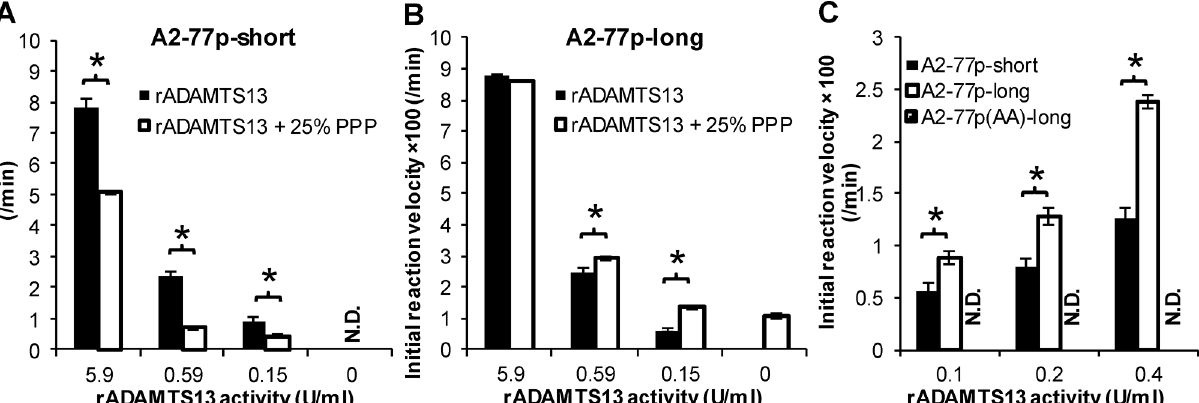
Fig 4. Effect of spacer length on proteolysis. A. A2-77p-short microspheres were incubated with varying concentrations of rADAMTS13 in the presence or absence of 25% plasma. Plasma failed to cleave A2-77p-short and also inhibited proteolysis of A2-77p-short by rADAMTS13. B. Experiments identical to panel A were performed, only using A2-77p-long. Here, plasma acts in synergy with rADAMTS13 to promote substrate cleavage. C. Direct comparison of the cleavage rates between A2-77p-short and A2-77p-long upon varying rADAMTS13 concentration. N.D. = cleavage not detected. * P < 0.05 for indicated